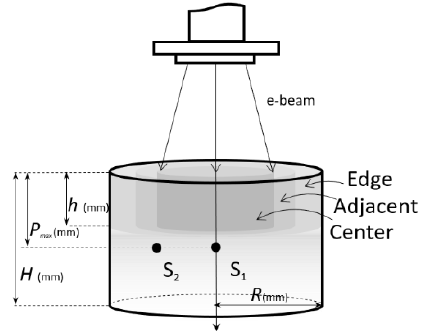
Figure 1. Experimental set-up.